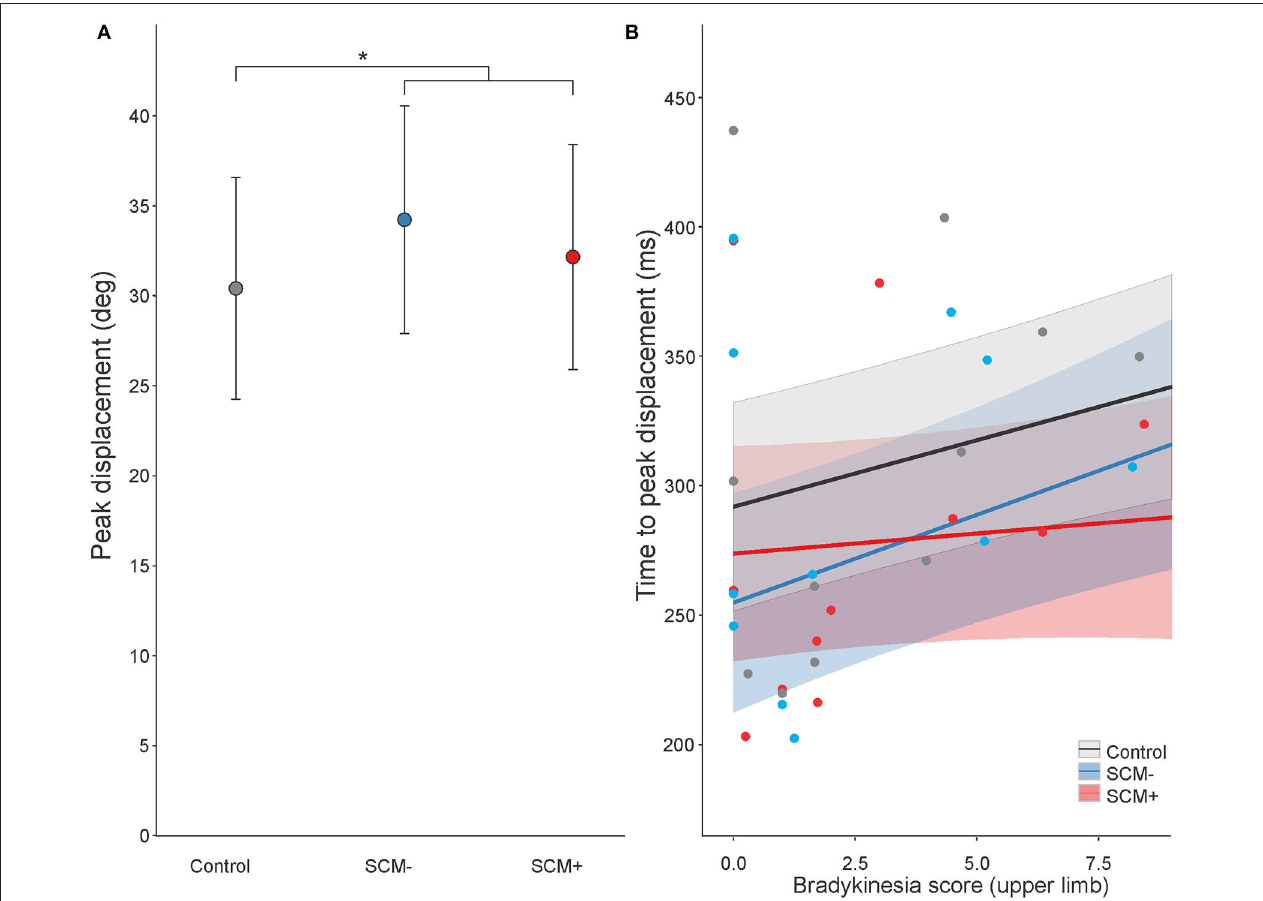
FIGURE 5 | Estimated marginal means (95% CI) for peak displacement as a function of stimulus condition (A) and model-fitted predicted time-to-peak displacement as a function of a bradykinesia score (B) . For time-to-peak displacement, the black line shows predicted values for control trials, the red line shows predicted values for startle trials where a startle reflex in sternocleidomastoid (SCM) was observed (SCM + ), and the blue line shows predicted values for startle trials where a startle reflex was not observed (SCM–). Shaded areas represent 95% CI. Dots represent participant mean values (note that these means are collapsed across tDCS sessions, which may have had different BK scores, and the model takes all individual data points into